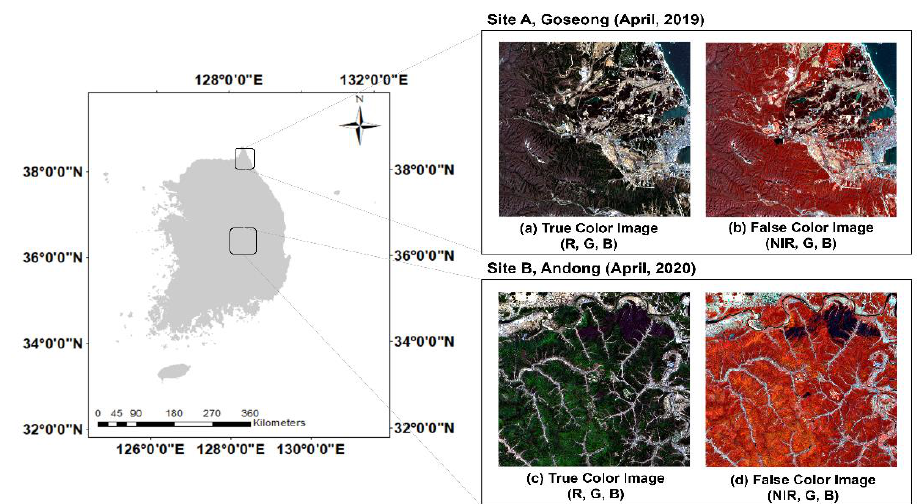
Figure 1. Study area (true color and false color composition of Sentinel-2 image). ( a ) True color image collected on April 2019 of Site A, ( b ) False color image collected on April 2019 of Site A, ( c ) True color image collected on April 2020 of Site B, and ( d ) False color image collected in April 2020 of Site B.